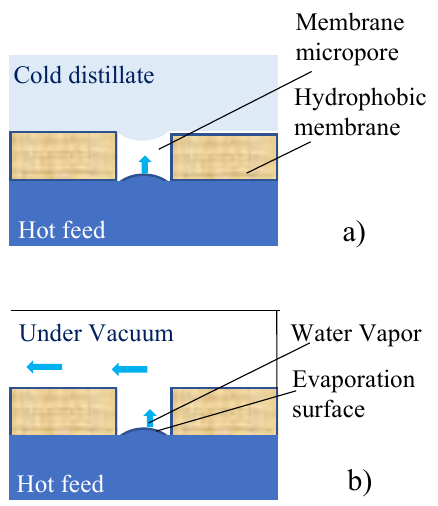
Figure 2. ( a ) DCMD and ( b ) VMD configurations.